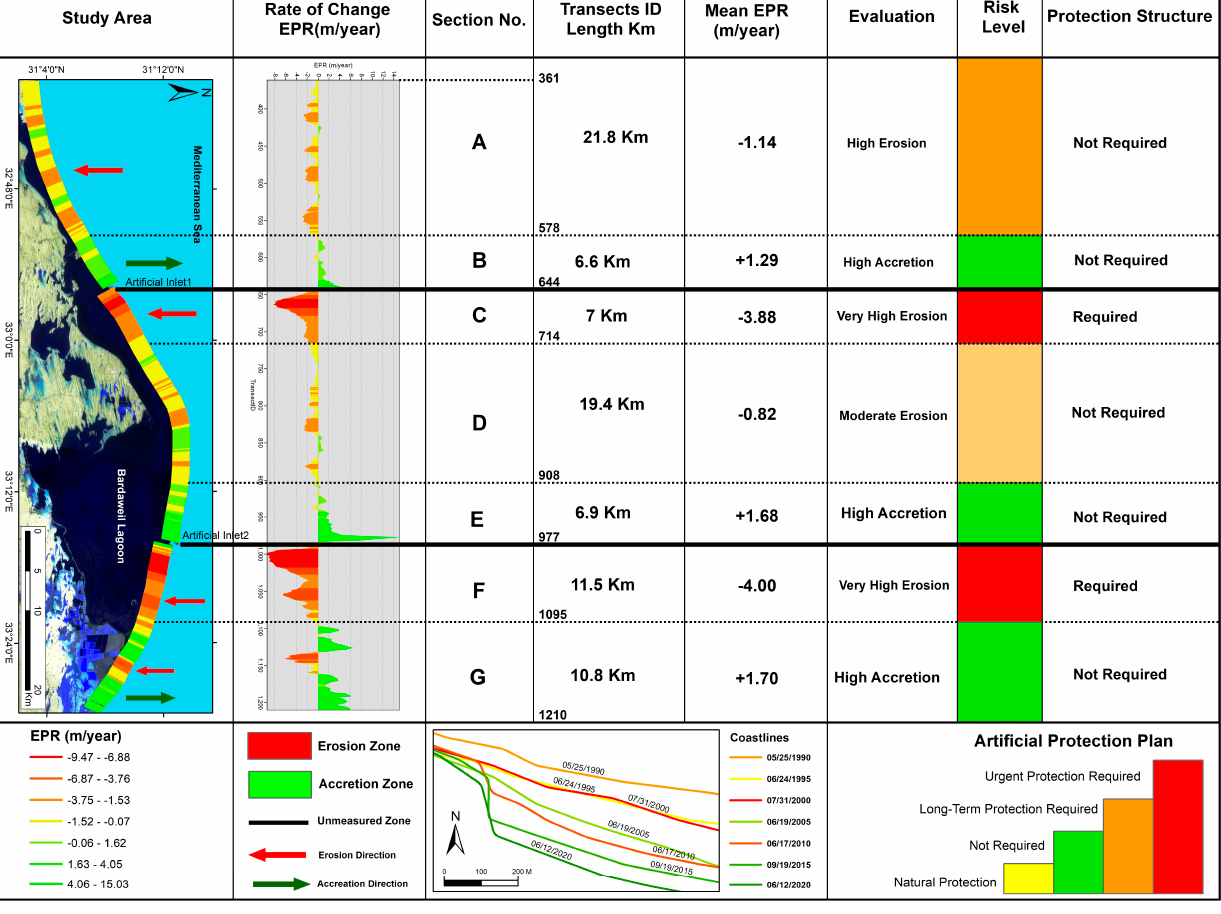
Figure 14. Coastal erosion management matrix along the Bardaweil Lagoon between 1990 and 2020.